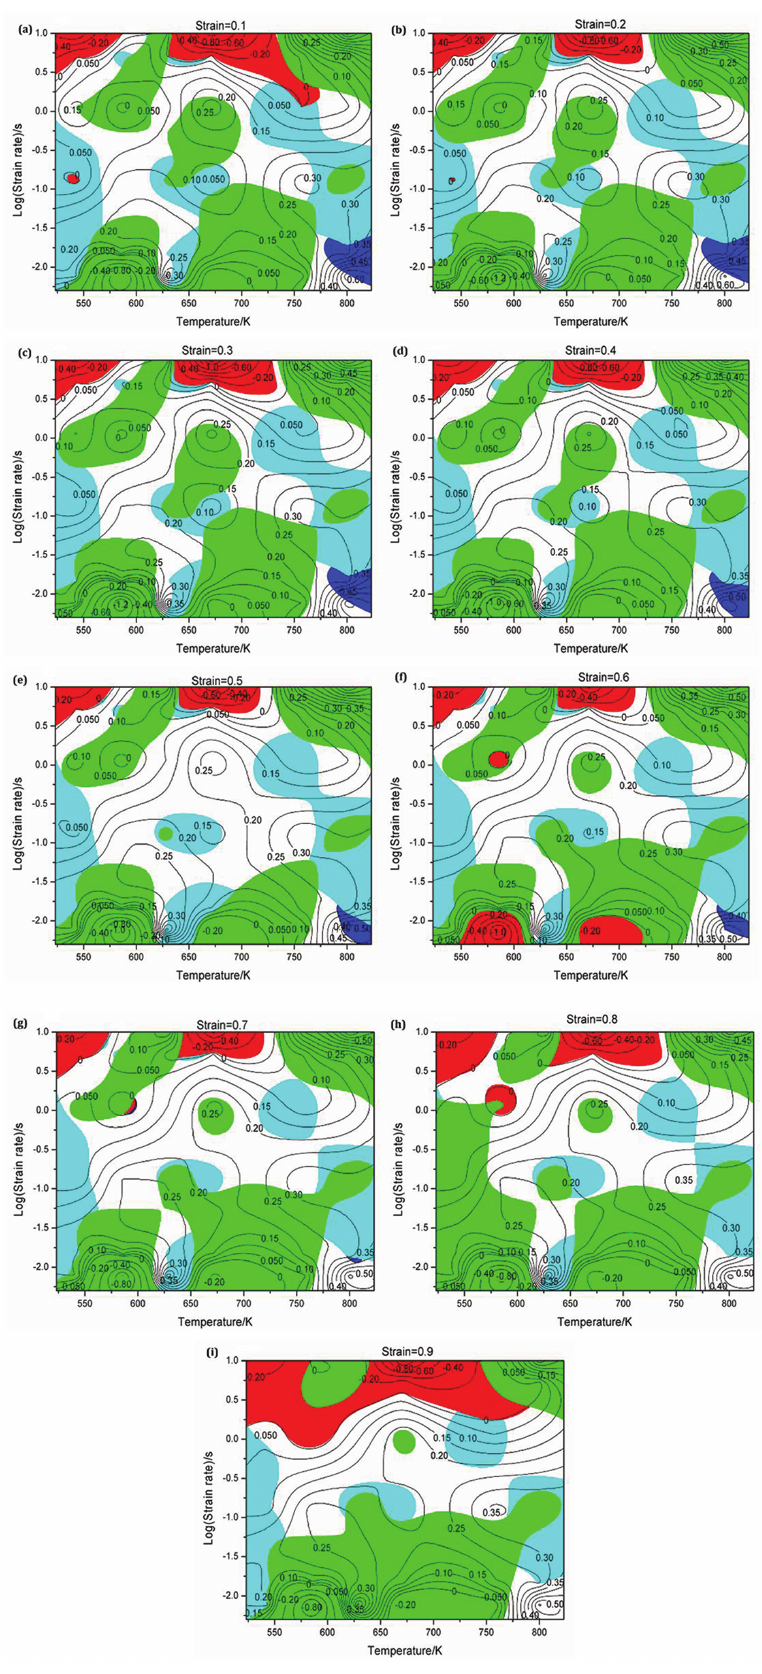
Figure 8: Processing maps of pure